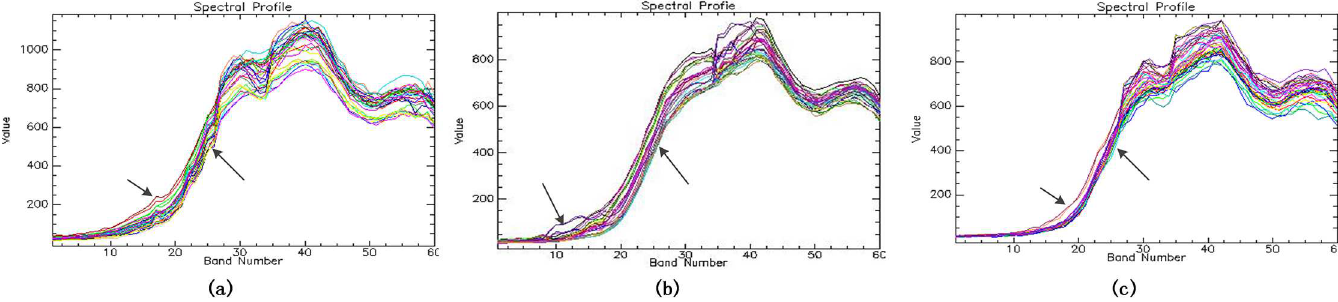
Fig 6. (a) spectrum of the hyperspctral vessel image before the registration,(b) after the initial registration,and (c) after the proposedregistration.